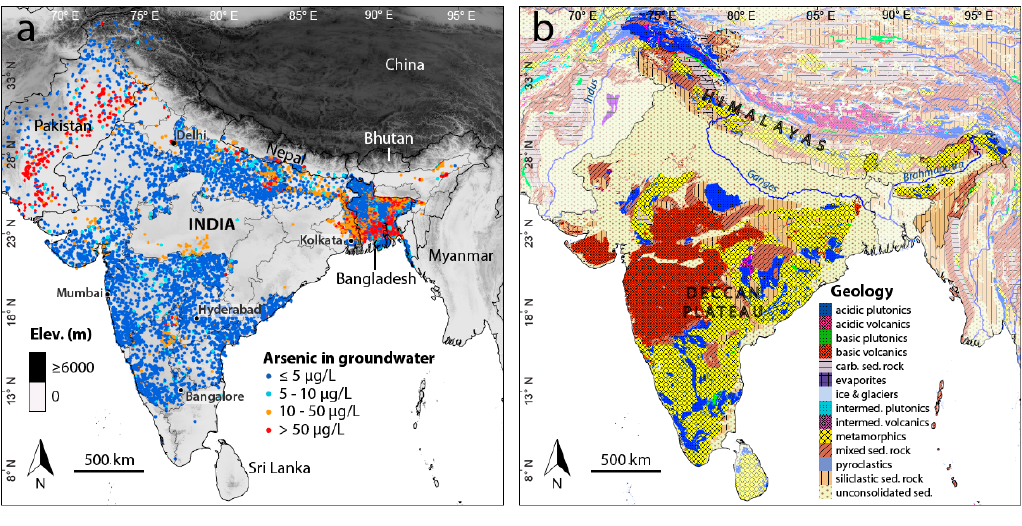
Figure 1. Groundwater arsenic data points and simplified geology of the Indian subcontinent. ( a ) Spatially averaged arsenic data points used in modeling along with topography in India and neighboring countries. ( b ) Lithology of the Indian subcontinent.